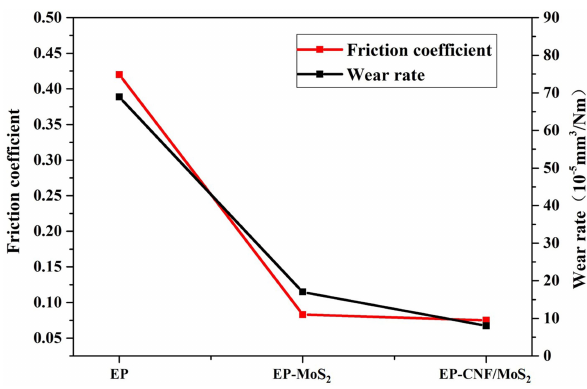
Figure 15: Variation of friction coeflcient and wear rate of coating